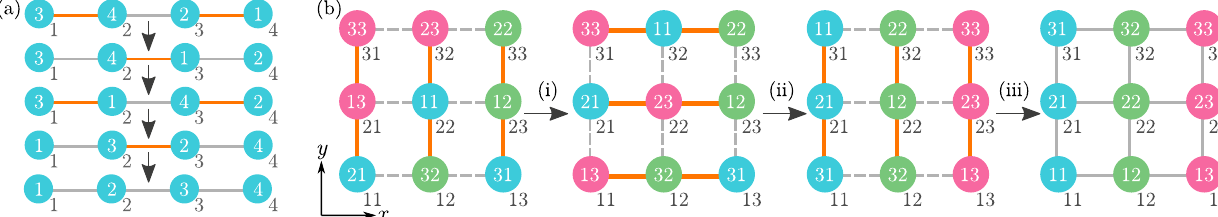
Fig. 6 Qubit permutations. These are shown for a linear and b rectangular devices. a Parallel neighbor sort for a linear device with N = 4 qubits using 4 consecutive layers of SWAP s. Qubits (circles) are labeled by fi nal positions as marked by gray numbers. Orange lines indicate qubit pairs which are compared at a given iteration and swapped, if in the wrong order. b Permuting N = 9 qubits (circles) in a square layout. Graph positions are labeled in gray. Labels on qubit circles indicate the fi nal row and column of each qubit. The permutation is implemented by consecutively using parallel neighbor sort along (i) columns, (ii) rows, and (iii) columns, as highlighted by orange